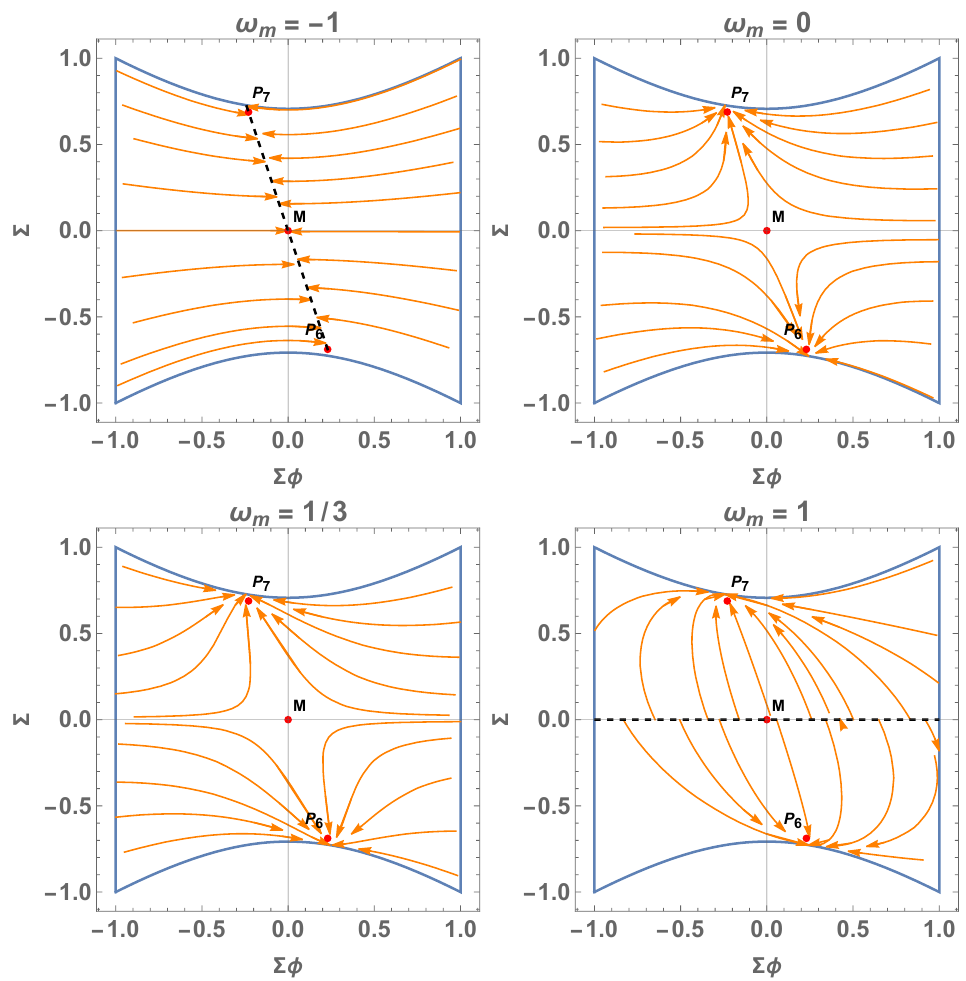
Figure 8. The 2D projection of (85)–(86) for (cid:101) = − 1, µ = 2, and different values of ω m